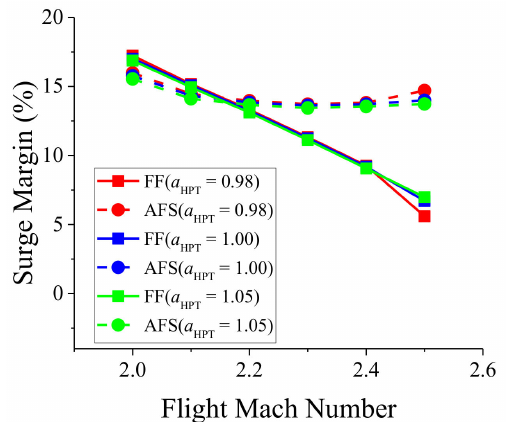
Figure 35. The Variations of Surge Margins of Front Fan and AFS at the conditions of Different Throat Area Coefficients of High-Pressure Turbine Inlet Guide Vane ( α HPT